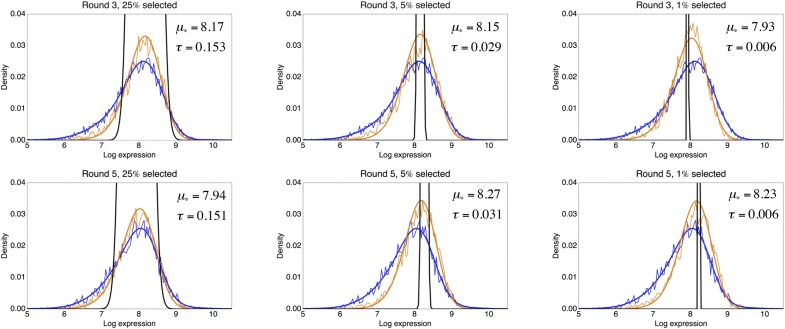
Inference of the fitness function from the observed log-fluorescence distribution before and after a round of selection.Each panel corresponds to one selection experiment with the title indicating on which population an extra round of selection was performed, that is, a population either from the third or fifth round of the evolutionary run for medium expression, and what fraction of the population was selected. The thin blue line indicates the observed log-fluorescence distribution p(x) before selection, and the thin orange line the observed distribution p′(x) after selection. The thick lines show the corresponding fitted distributions. The inferred selection window f(x|μ*,τ), that is, Equation 69, is indicated in black, and its parameters μ* and τ are indicated in each panel as well.